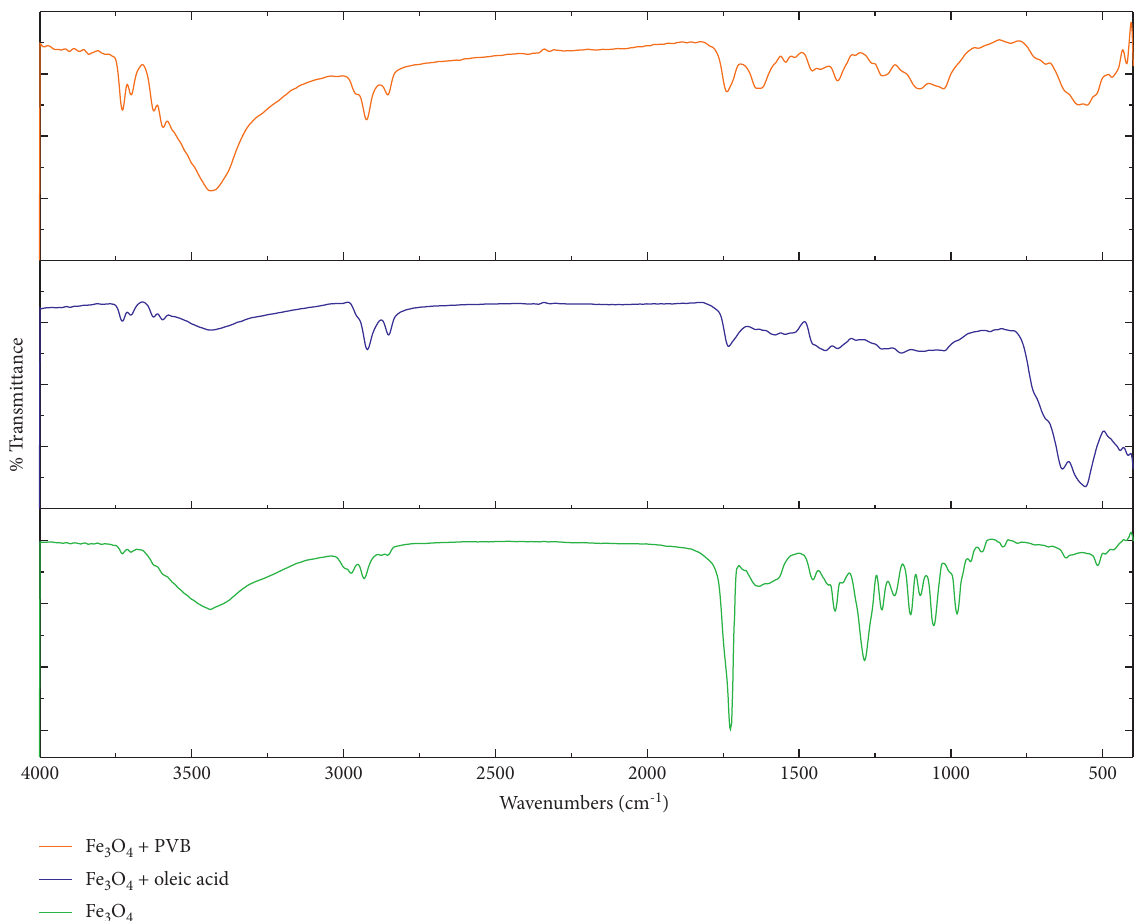
Figure 3: FTIR spectrum of all the forms of Fe